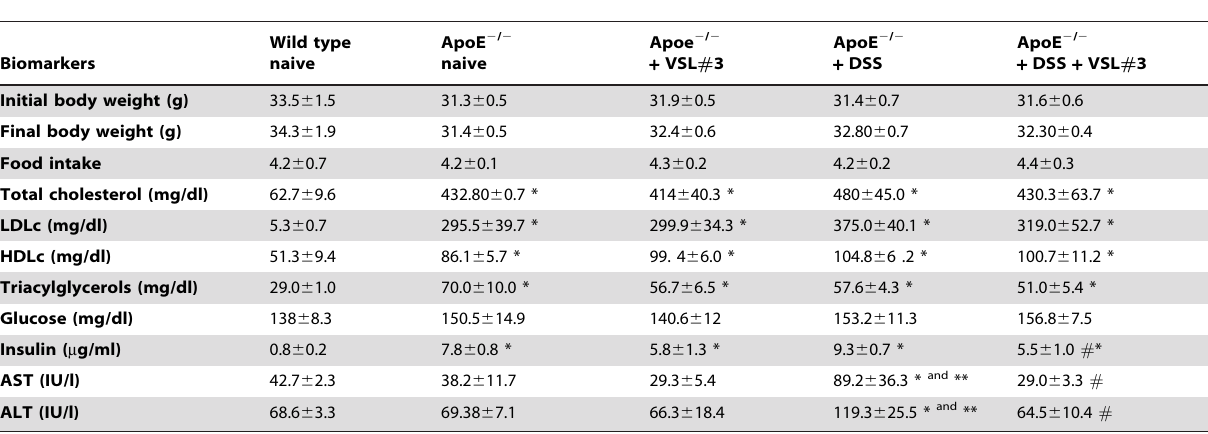
Table 1. Effects of VSL # 3 intervention on clinical and biochemical parameters.